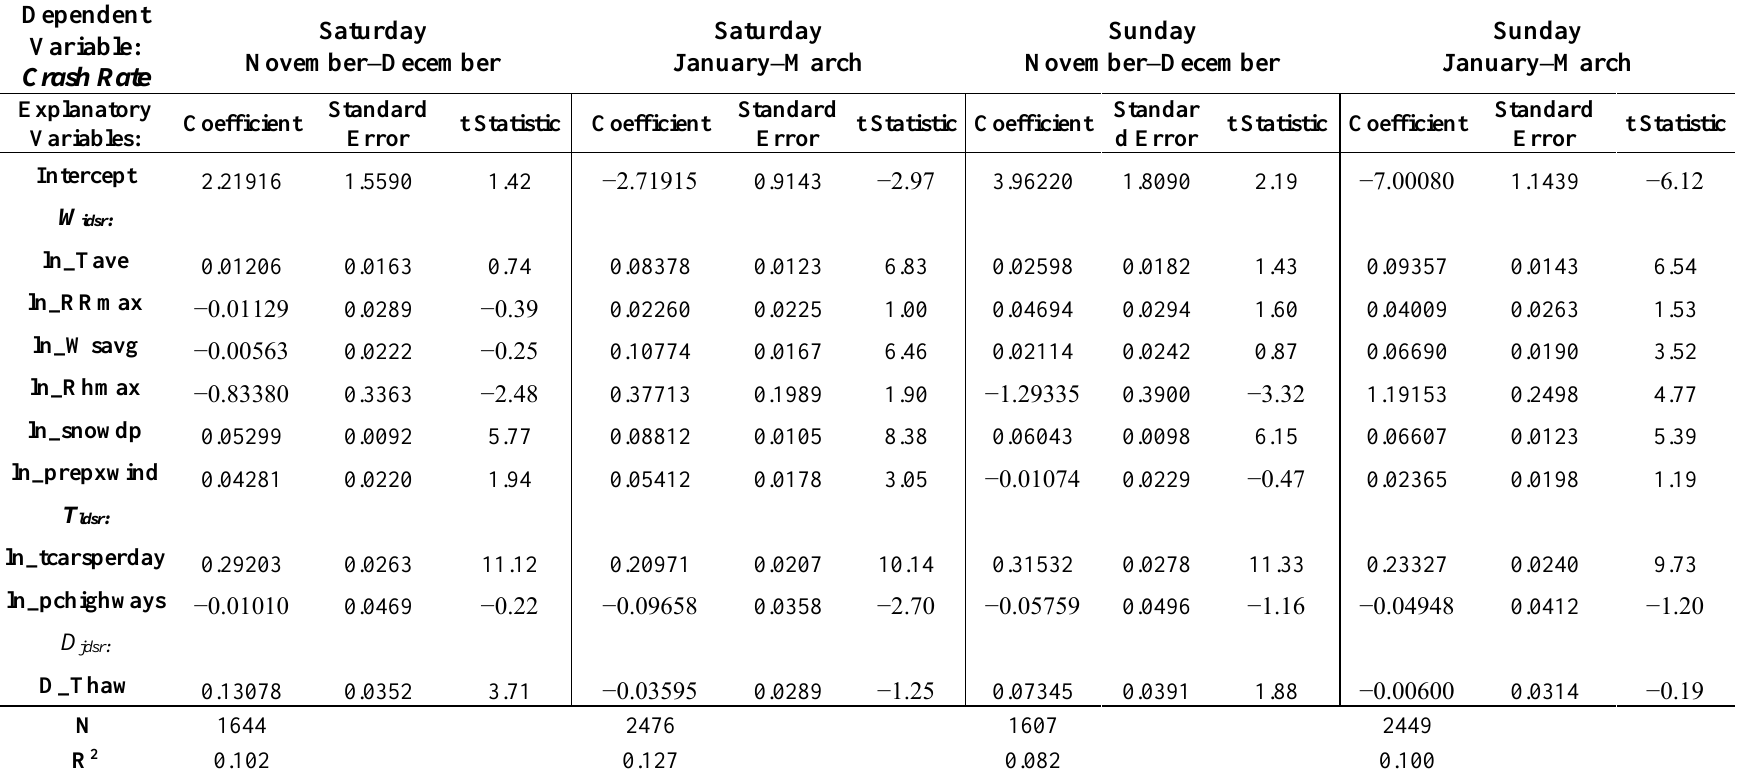
Table 3. Regression estimations for Saturday and Sunday for all regions